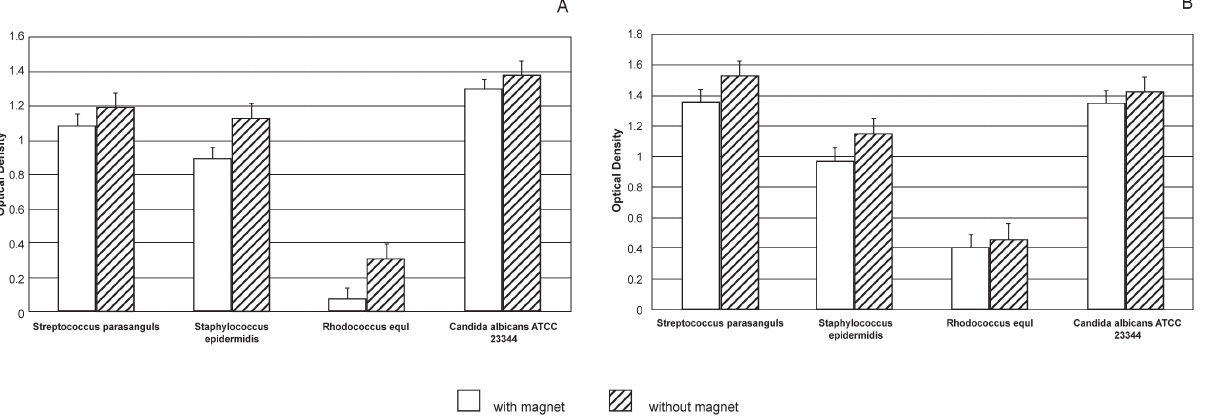
Figure 2- Optical density values upon 24 and 48 h of incubation with a inoculum density of 10